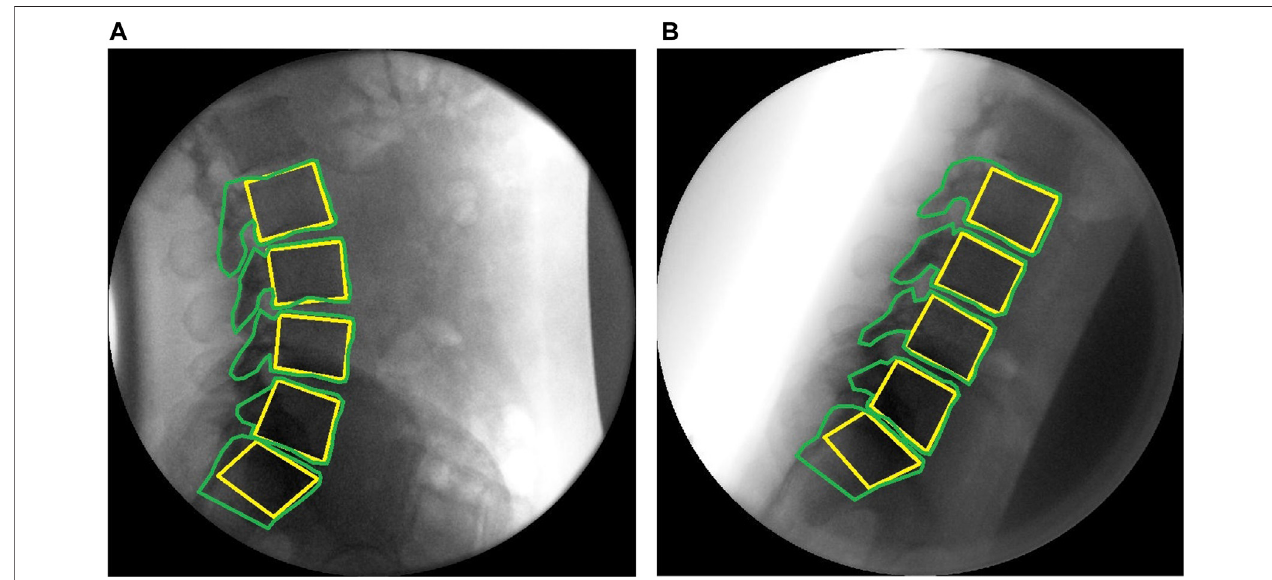
FIGURE 2 | Sagittal plane fl uoroscopic images of the lumbar spine with computer templates (A) upright (B) fl exed.